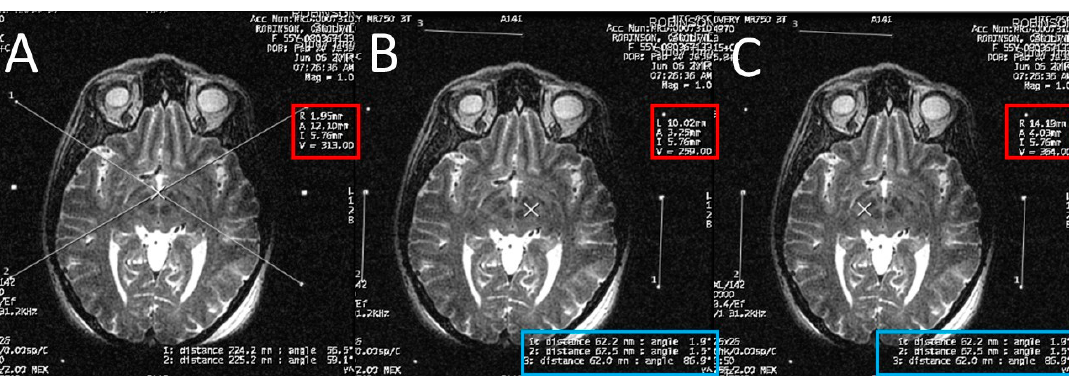
Figure 4. Calculating the subthalamic nucleus (STN) coordinates from the magnetic resonance imaging (MRI) console. ( A ) two diagonal lines intersecting at the center of the frame at the STN level with MRI coordinates of the center of the frame shown inside the red square; ( B ) a crosshair at the center of the left STN, with its MRI coordinates shown inside the red square, two line are drawn between the middle and lower fiducials on both sides of the frame and their lengths (in the blue rectangle) are used to calculate the Z coordinate; ( C ) a crosshair at the center of the right STN, with its MRI coordinates shown inside the red square, two line are drawn between the middle and lower fiducials on both sides of the frame and their lengths (in the blue rectangle) are used to calculate the Z coordinate.